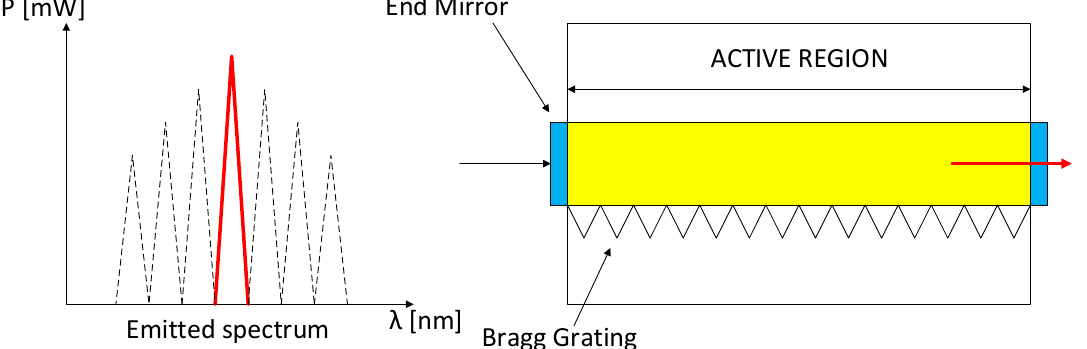
Figure 5. Schematic diagram of the DFB